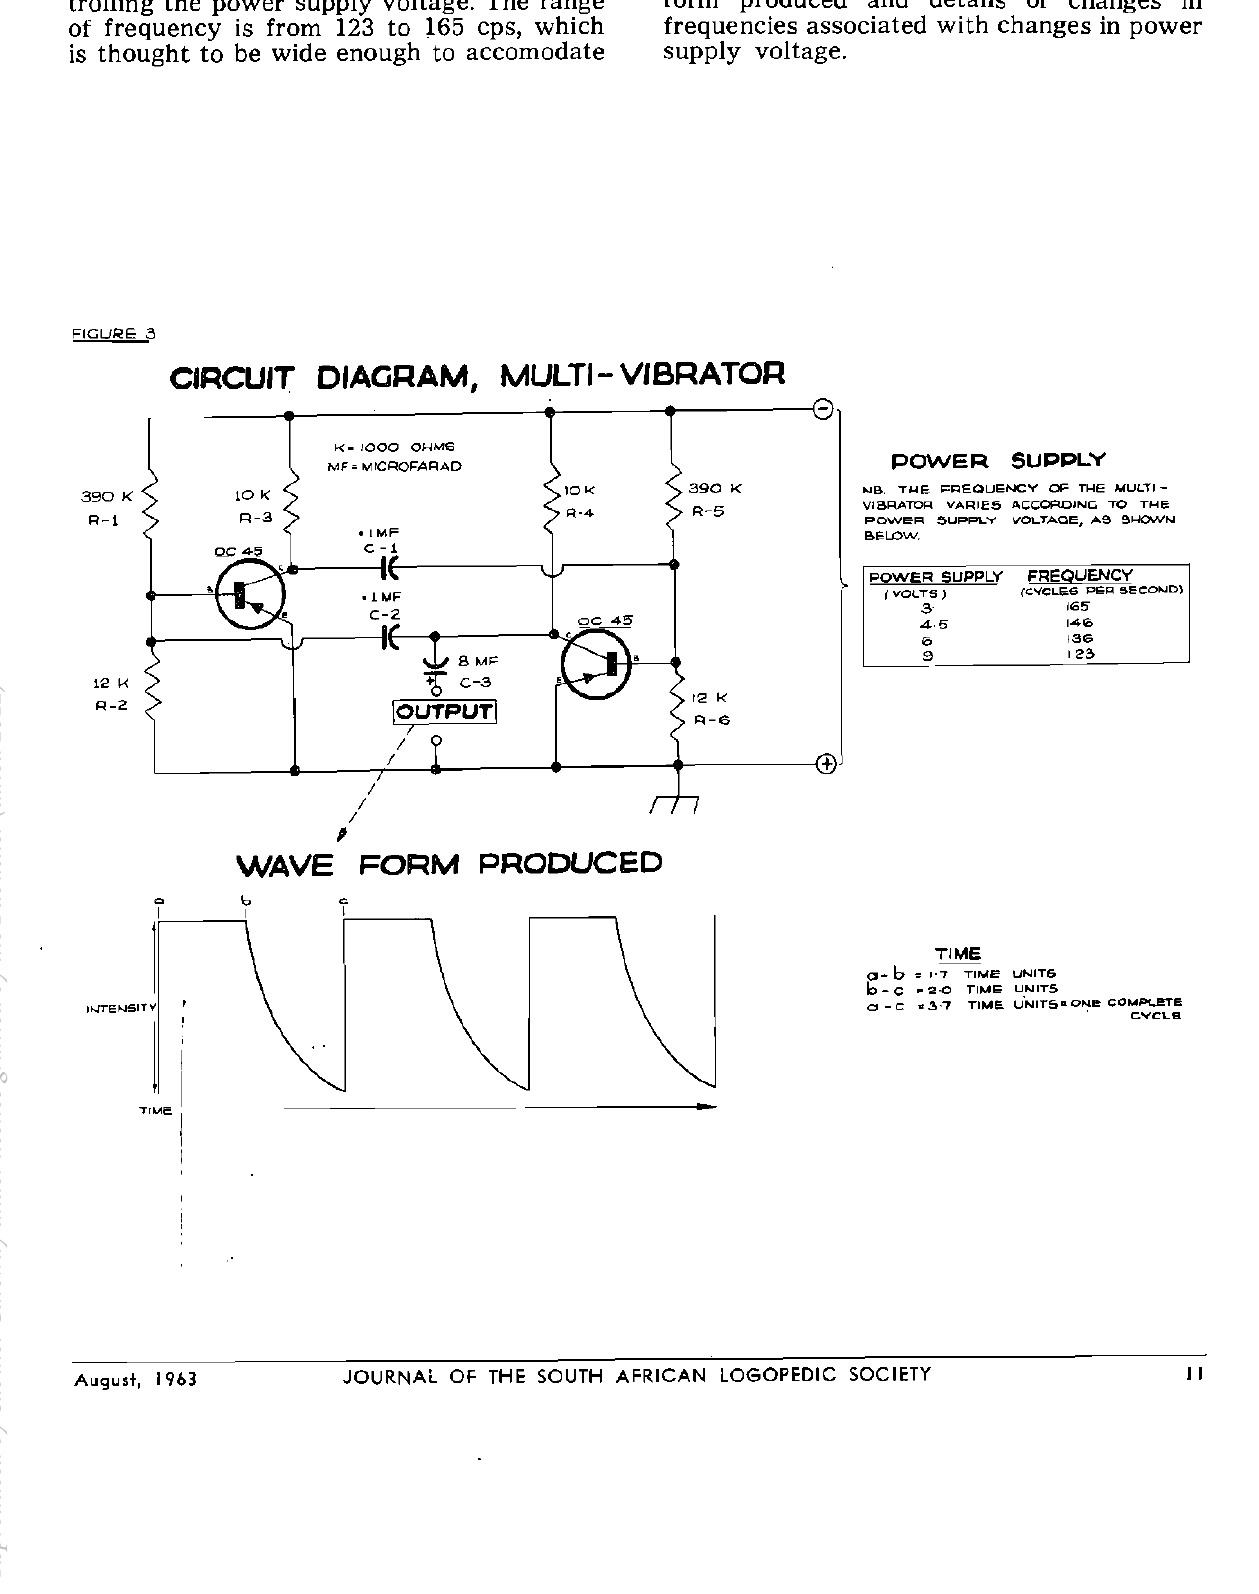
FIGURE 3 CIRCUIT DIAGRAM, MULTI-VIBRATOR